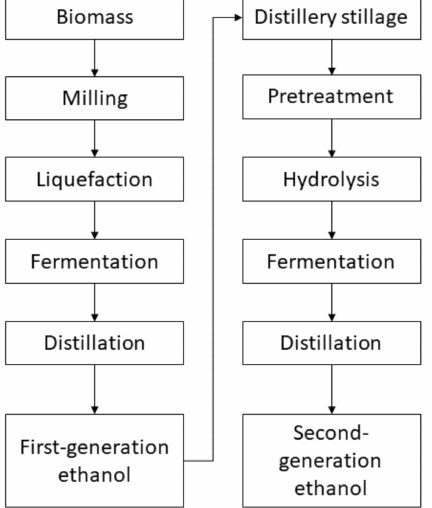
Figure 3. First- and second-generation ethanol production. Table 3. The efficiency of the ethanol fermentation process using stillage. Type of